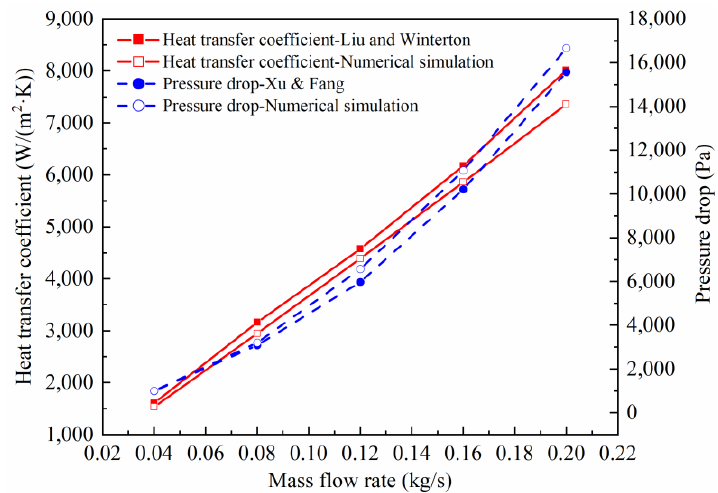
Figure 4. Validation of present study with empirical correlations.